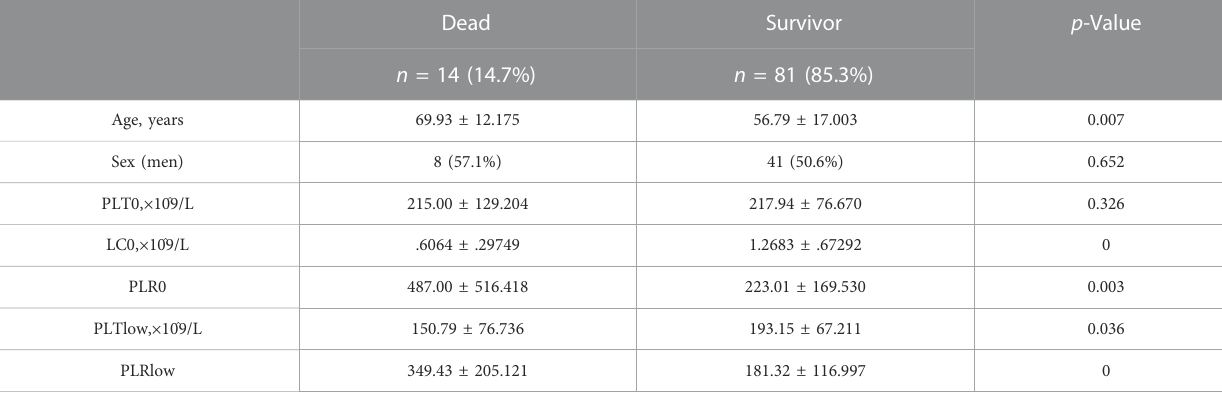
TABLE 2 Demographic characteristics and laboratory parameters of dead and non-dead patients.